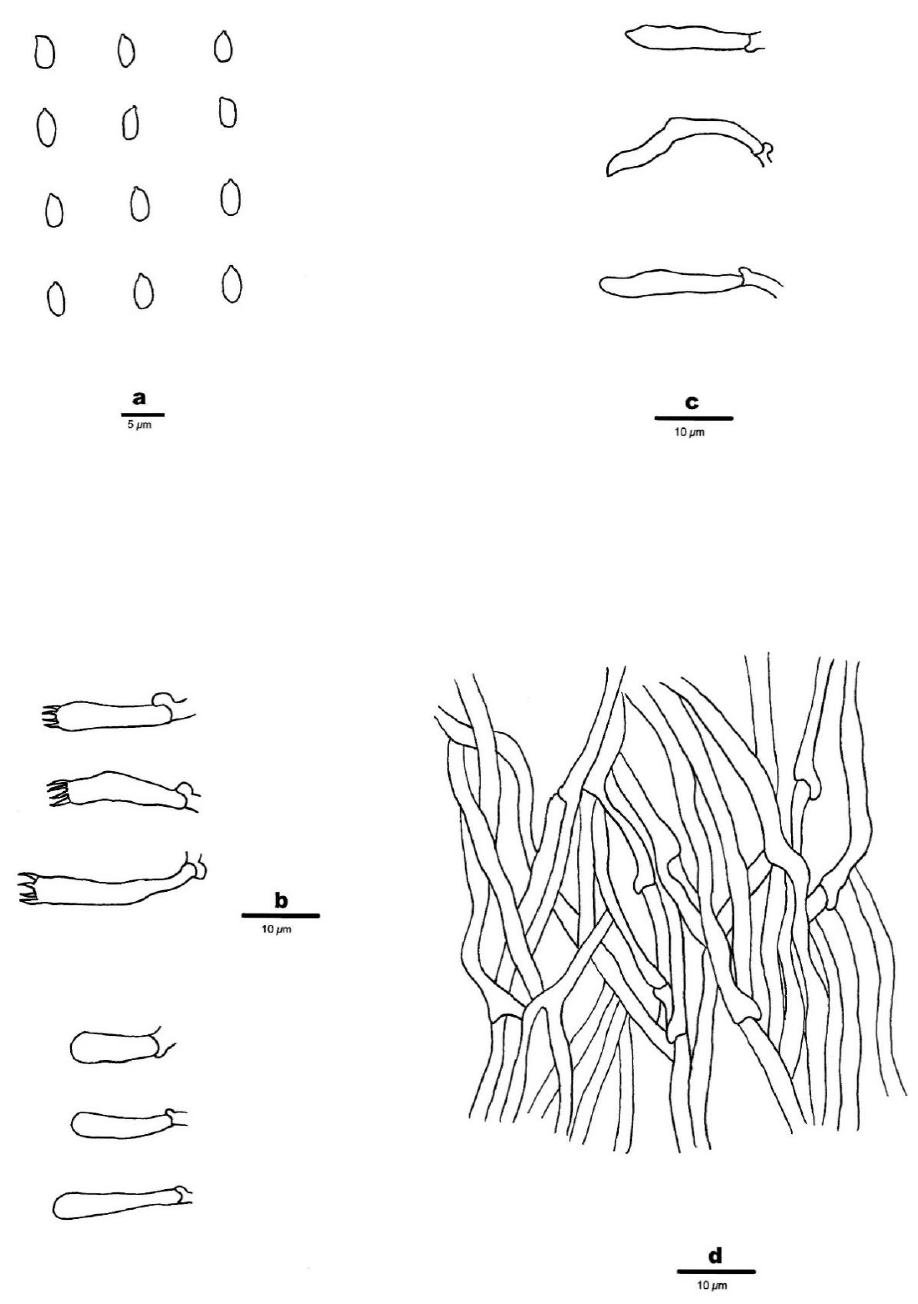
Figure 4. Microscopic structures of Phlebia austroasiana (Holotype, Dai 17556). ( a ) Basidiospores. ( b ) Basidia and basidioles. ( c ) Cystidia. ( d ) Hyphae from spine trama. Drawings by: Zhan-Bo Liu. MycoBank number: MB